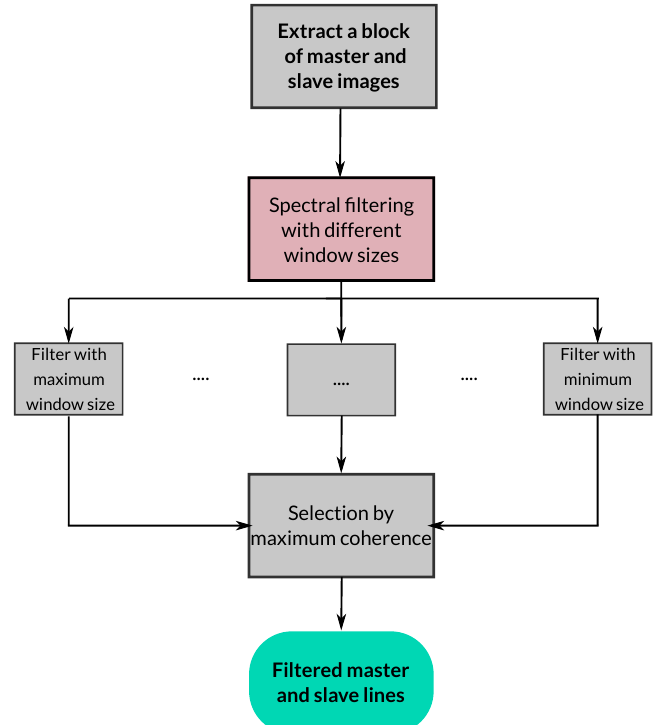
Figure 7. Block diagram of the proposed range-filtering